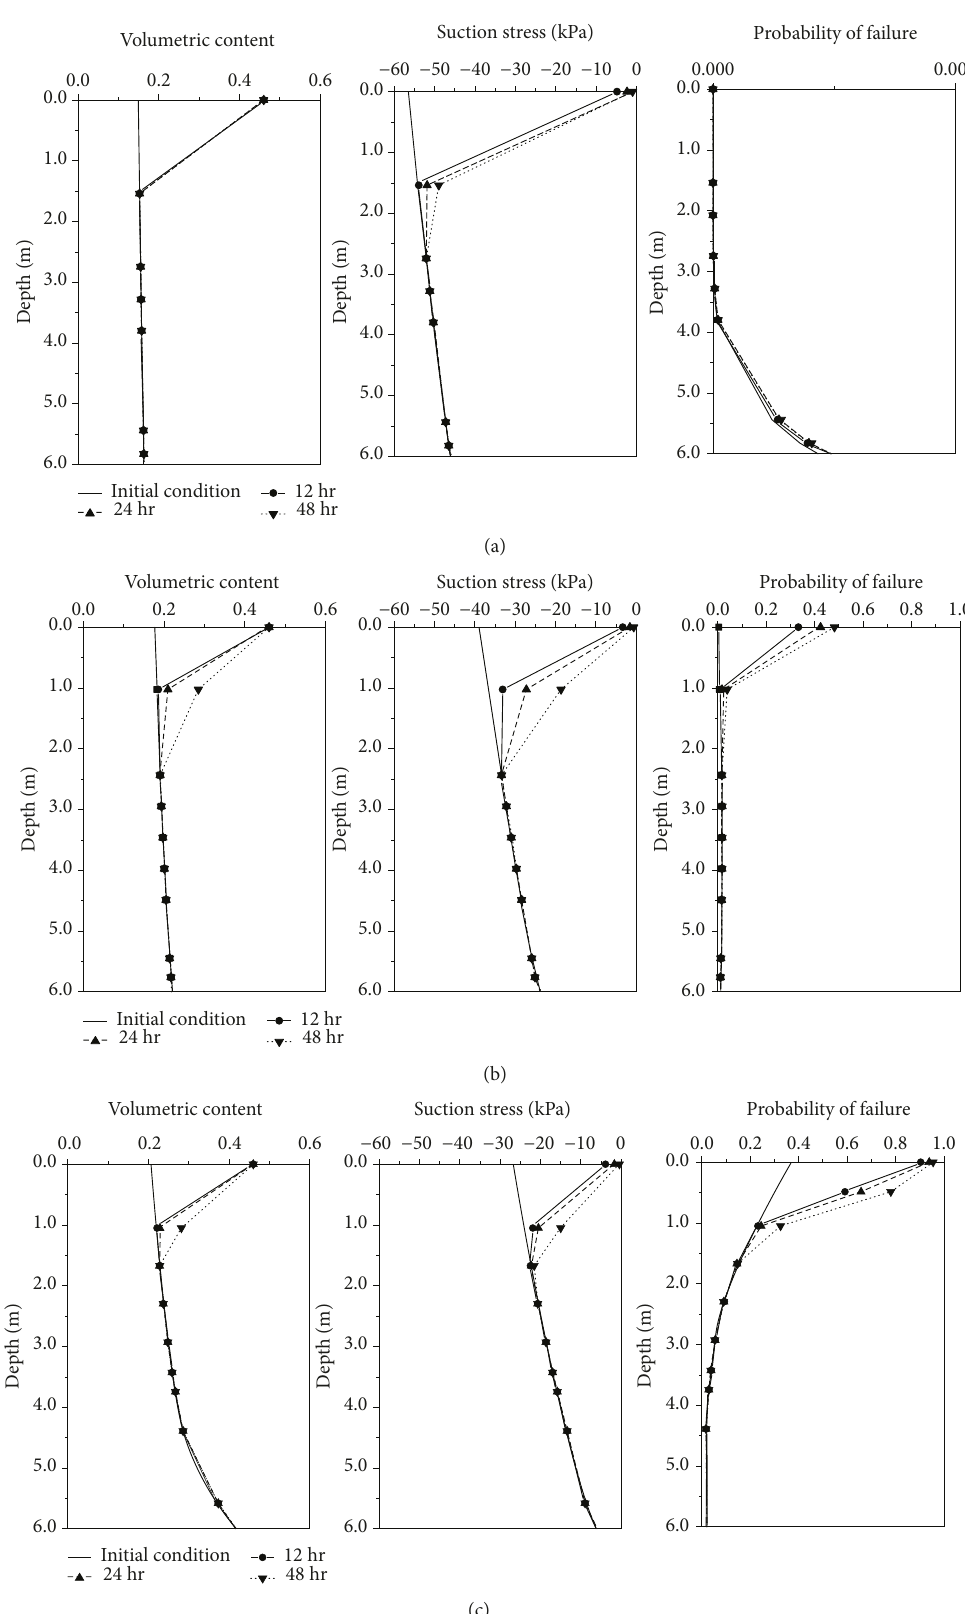
Figure 9: Results of water content, suction stress, and failure probability in the silt slope at 0, 12, 24, and 48 hours under rainfall conditions (a) at the top of the slope, (b) middle of the slope, and (c) toe of the